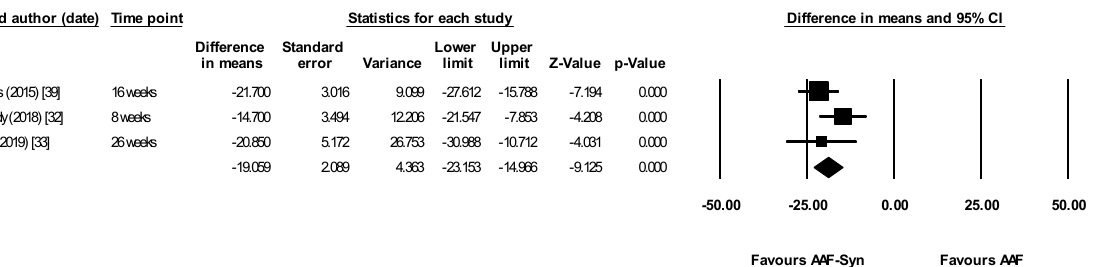
Figure 5. Meta-analysis showing significantly lower percentages of adult-like Eubacterium rectale and Clostridium coccoides species with AAF-Syn . Abbreviations: AAF-Syn: amino acid formula with synbiotics. AAF: amino acid formula. CI: confidence intervals.